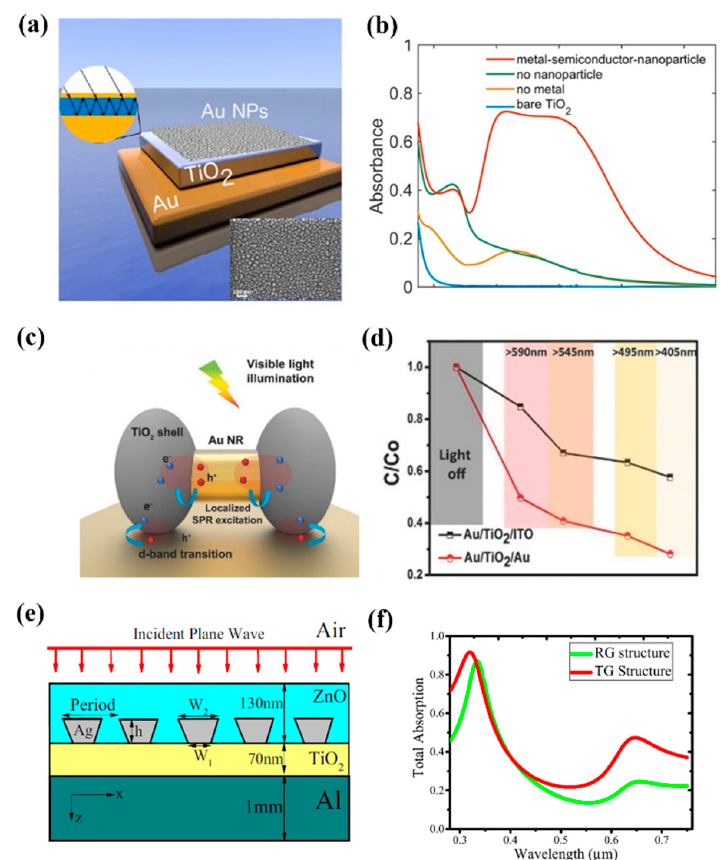
Figure 5. The design of the plasmonic cavity for broad band photons trapping. ( a ) The schematic of Au NPs-TiO 2 layers-Au films “sandwich structures” (the inset is the transportation of incident photons between Au NPs and Au films). ( b ) The comparison of the absorption spectrum in absorbers-spacer-mirror (ASM) structures with control groups. ( a , b ) Reproduced with permission. [74] Copyright 2016, American Chemical Society. ( c ) The band diagram and flow of HCs in Au nanorods-TiO 2 dumbbells/Au films under visible light illumination. ( d ) The comparison of rates of decomposing MB in Au/TiO 2 /ITO and Au/TiO 2 /ITO under different wavelengths of the incident light, respectively. ( c , d ) Reproduced with permission. [75] Copyright 2018, Wiley-VCH. ( e ) The scheme of surface plasmon polaritons (SPPs)-mediated broadband light absorption structures, which was built up by pattered Ag gratings, TiO 2 layers and Al films (from top to bottom). ( f ) The total absorption of rectangular gratings (RG) and trapezoidal gratings (TGs) on top, respectively. ( e , f ) Reproduced with permission. [78] Copyright 2018, Springer.